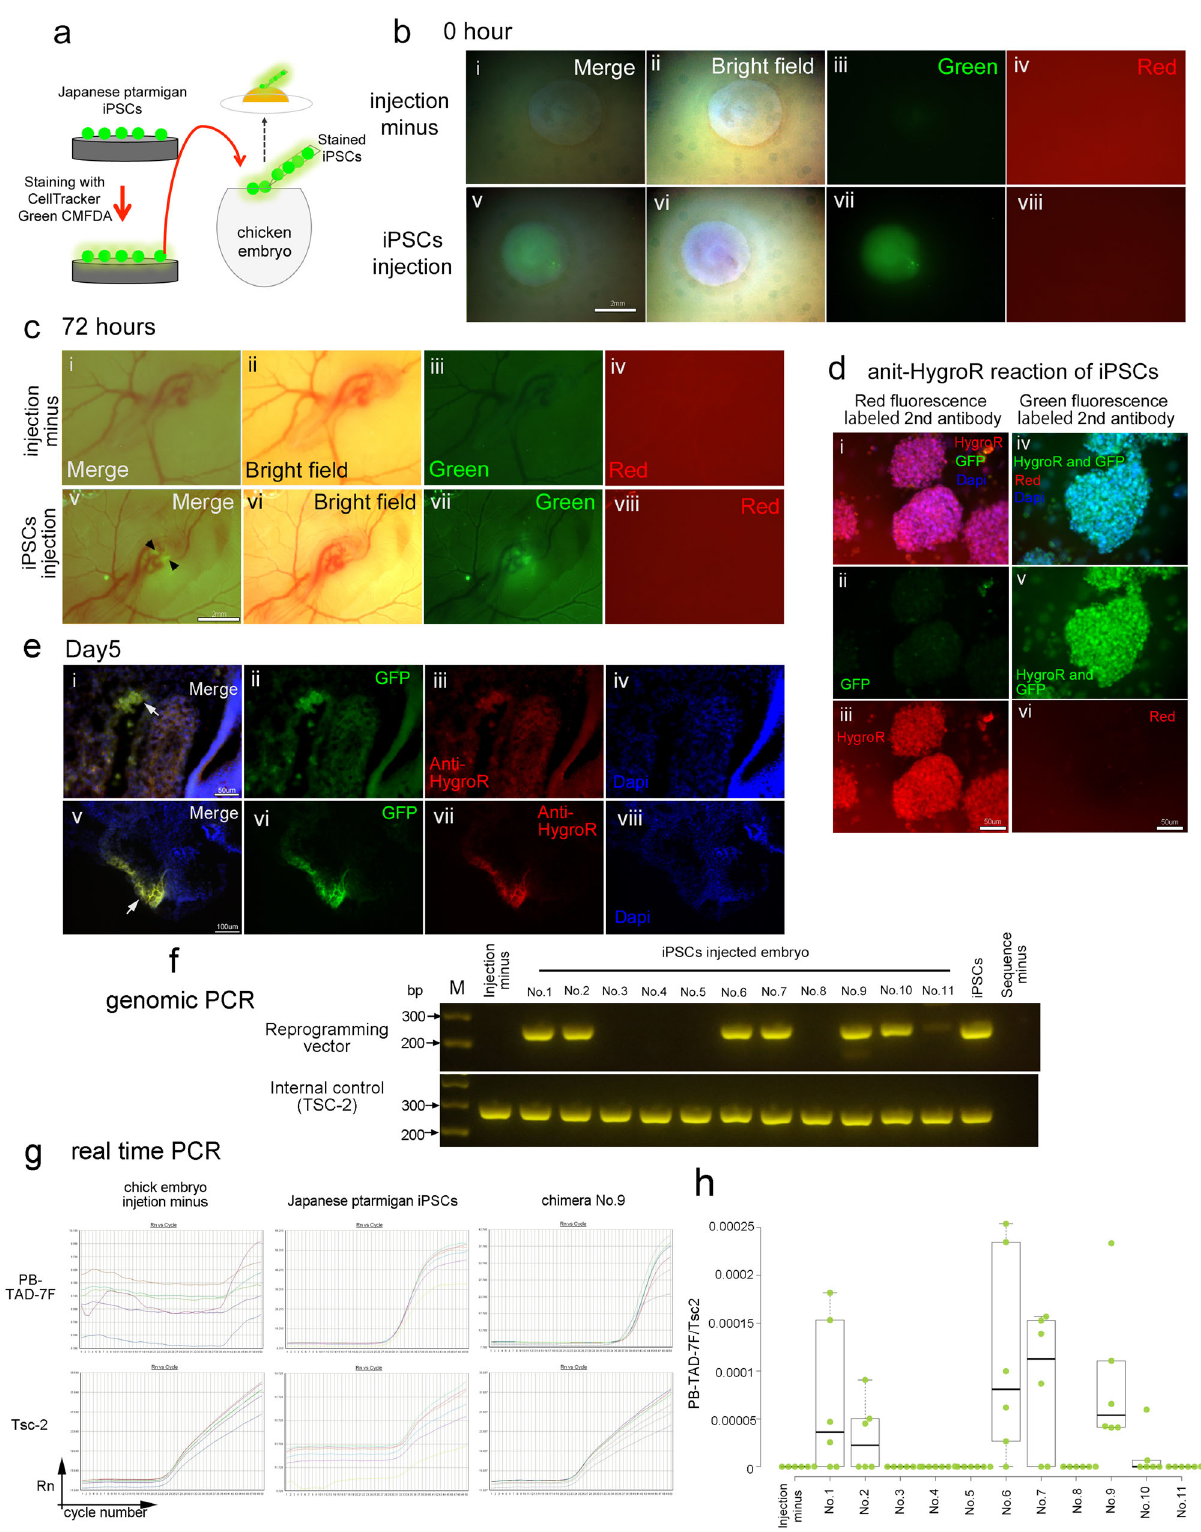
out bird banding, of wild birds with identi fi cation tags. The emerging pinfeathers we used had been accidentally release during banding. The banding had been performed by a veterinarian at the Institute for Raptor Biomedicine Japan (IRBJ) in the Hokkaido area on June 2, 2006. IRBJ is a private organization that primarily focuses on emergency medicine fi rst aid and care for wild avians in Hokkaido region of Japan. IRBJ is contracted to MOE to handle and administer fi rst aid for endangered animals. The MOE banding ring was 14C0242. Since banding was carried out with the permission of MOE for capturing wildlife, we did not